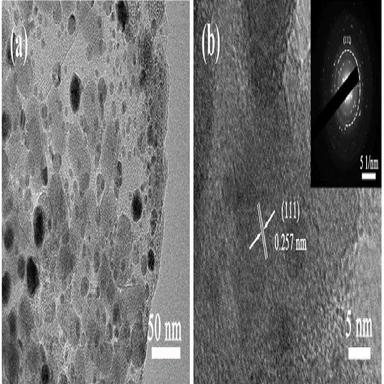
TEM (a) and HRTEM images (b) of SAC-MnO-0.020.